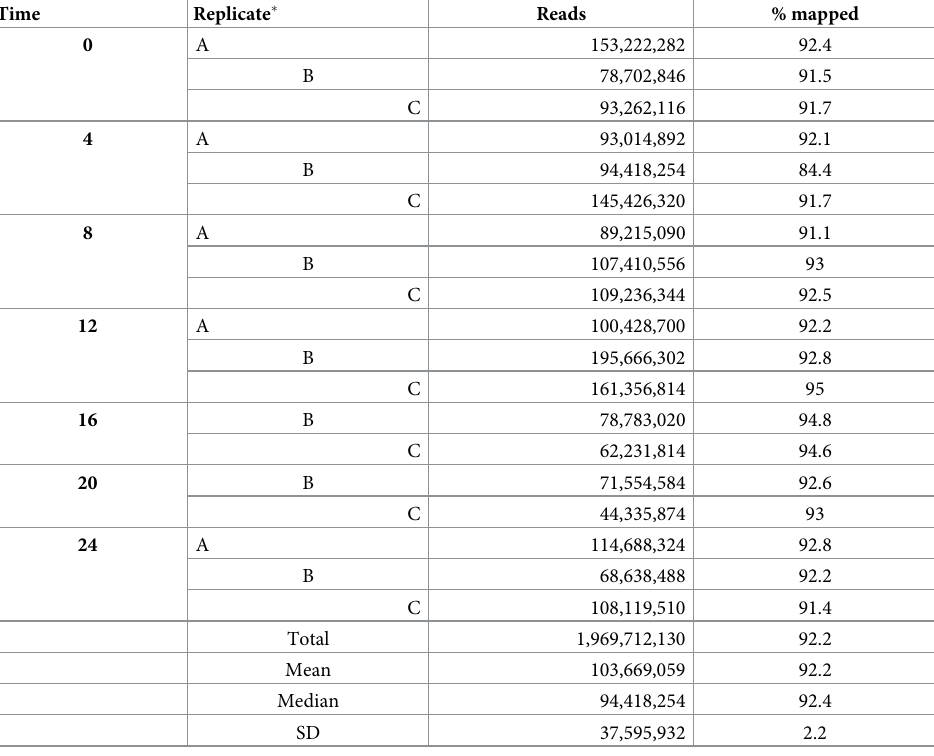
Table 1. E . acervulina oocyst RNA-Seq reads depth and quality. Time Replicate �